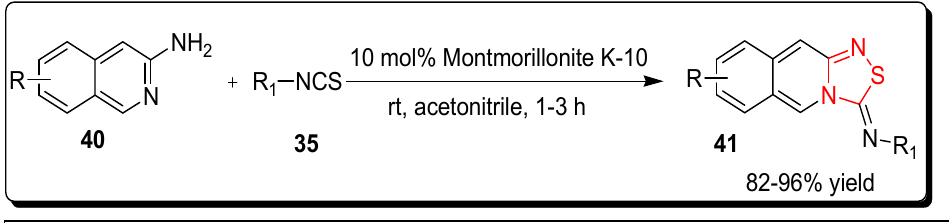
Scheme 17. Green synthesis of N -fused imino-1,2,4-thiadiazolo isoquinolines 41 .